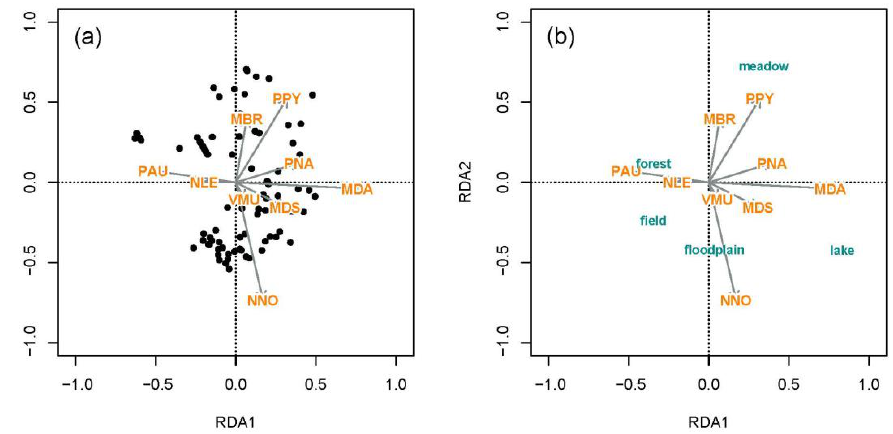
Figure 4. Results of redundancy analysis revealing the relationship between the areas of different land cover types and assemblage structure at the site level. ( a ) Overlay of samples (at each mist-netting site) and species shown by grey arrows and orange 3-letter bat species abbreviations. ( b ) Overlay of species shown with grey arrows and land cover types shown in green – blue: forest, lake, meadow, field and floodplain. At the plot level, the overall RDA model explained 26.1%. The proportion of variation explained by land cover types was 41.9%. The fitted model was not significant (F 5,5 = 0.72, p = 0.7). The negative values on RDA 1 reflected fields, whereas the positive ones reflected the higher share of lake areas (Supplementary Material, Figure S3). The RDA 2 reflected another gradient from field (negative values) to forest and meadow (positive values); however, these redundancy scores were not significant. Association of Bat Assemblages with Forest Age Structure At the site level, the overall RDA model explained 51.9% of variation, and the amount of the constrained variation explained by different forest age classes was 11.5%. The first RDA axis reflected a gradient of forest age ranging from young forest (11 – 40 years old) and clear cuts (negative values) to old forest (91 – 150 years old; Figure 5). The second RDA axis reflected a gradient from clear cut (negative values) to the oldest forest in the area of more than 150 years old. The overall model was significant (F 5,95 = 2.5, p = 0.001) and the first RDA was significant (F 1,95 = 7.77, p = 0.001). Among the explanatory variables, two were significant: the area of the young forest 11 – 40 years old (F 1,95 = 7.28, p = 0.001) and the area of the old forest of more than 150 years old (F 1,95 = 3.23, p = 0.01). Among the species, only PAU was associated with clear cuts and young forest stands of 11 – 40 years old, whereas all other species tended towards older forest stands of at least 41 years old. At the plot level, the overall RDA model explained 26.1% of data variation. The pro- portion of constrained variation explained by the forest age classes was 78.8%. The first RDA axis reflected a gradient from young forest (11 – 40 years) and clear cut (negative val- ues) to old forests (91 – 150 years old; positive value). The second RDA axis reflected the gradient from clear cut (negative value) to the oldest forest stands (more than 150 years